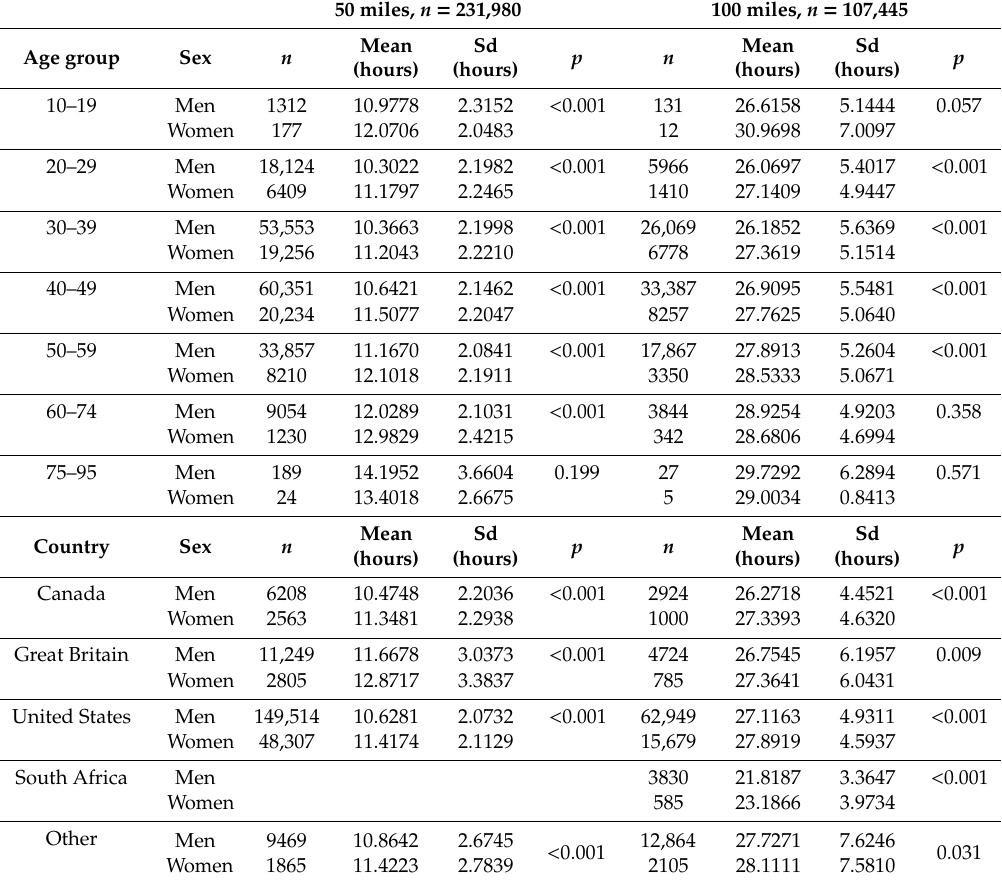
Table 1. Mean ultra-marathon performance (50 and 100 miles) by sex, age group, and country (South Africa, due to a small sample size for 50-mile races, is combined with other countries). p -values of a t-test of mean performance between sexes are